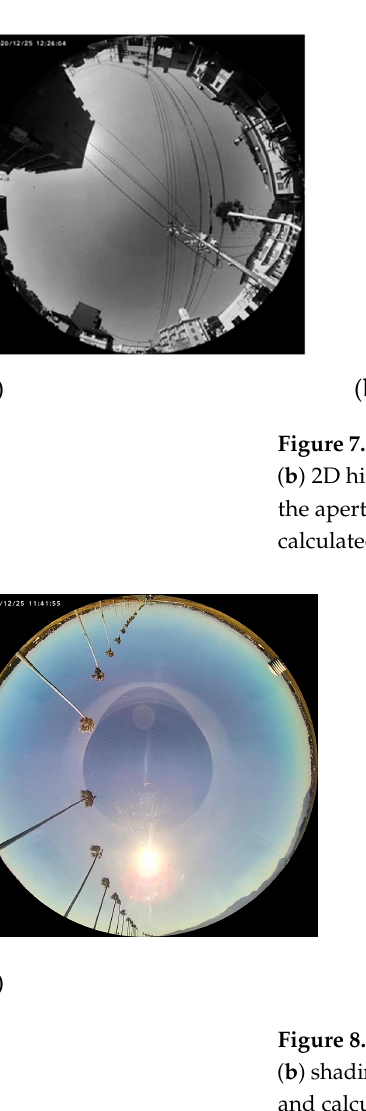
Figure 6. Definition of the grazing angle and orientation angle in the hemispherical sky.